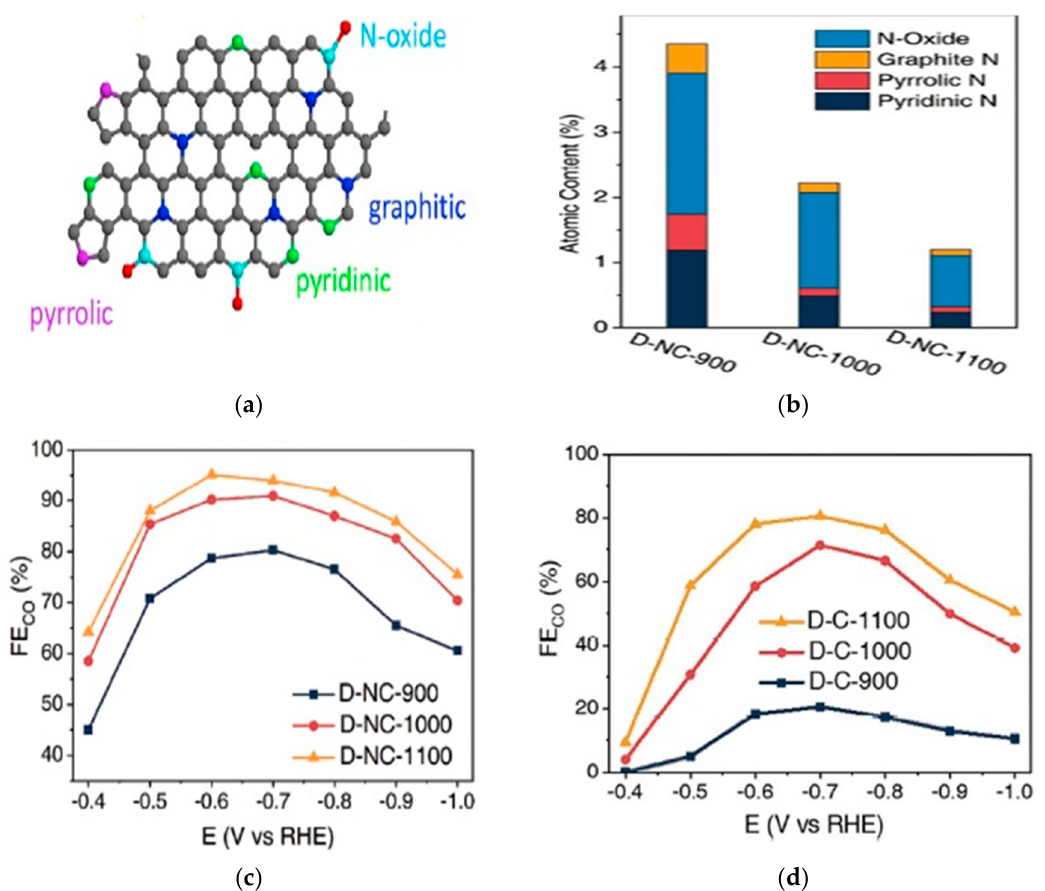
Figure 1. ( a ) Nitrogen atom configuration in a graphene network, reproduced from [80], Copyright (2020), with permission from Elsevier; ( b ) N content of doped material D-NC-1100; ( c ) Faradaic efficiency to CO (FE CO ) versus applied potential of the N-doped catalysts; ( d ) FE CO versus the applied potential of the un-doped catalyst, reproduced from [78], Copyright (2020), with permission from John Wiley and Sons.